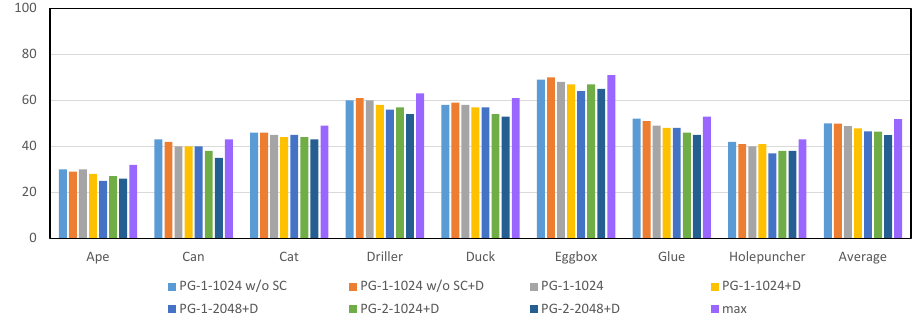
Figure 5. Statistics of false projection selection per one hundred channels on Occluded LineMOD dataset [6]. All test methods here are the same as Figure 4.